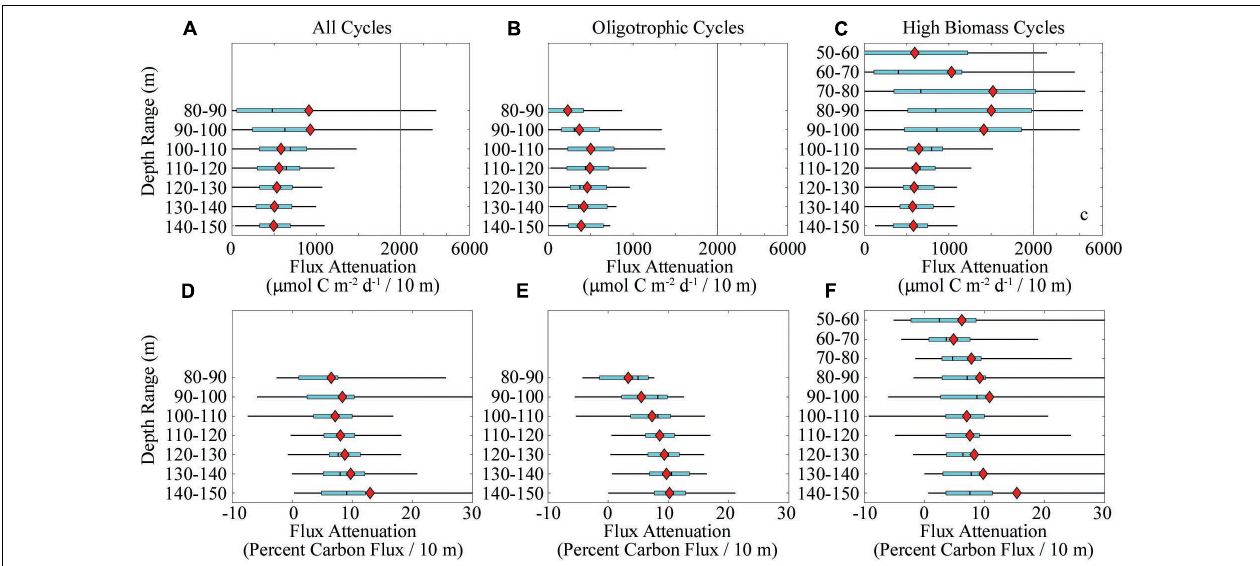
FIGURE 3 | Carbon flux attenuation determined by merging sediment trap and 238 U– 234 Th deficiency data. Panels (A–C) show absolute flux attenuation over 10 m depth bins (note break in flux scale at 2000 µ mol C m − 2 day − 1 /10 m). Panels (D–F) show relative flux attenuation over 10 m depth bins. In all panels, light blue boxes show quartiles (median is black line) and thin black lines show 95% confidence intervals (computed using MATLAB function quantile). Red diamonds are arithmetic mean value. Panels (A) and (D) show data for all cycles. Panels (B) and (E) show data for cycles with surface chl < 0.5 µ g Chl a L − 1 . Panels (E) and (F) show data for cycles with surface chl > 0.5 µ g Chl a L − 1